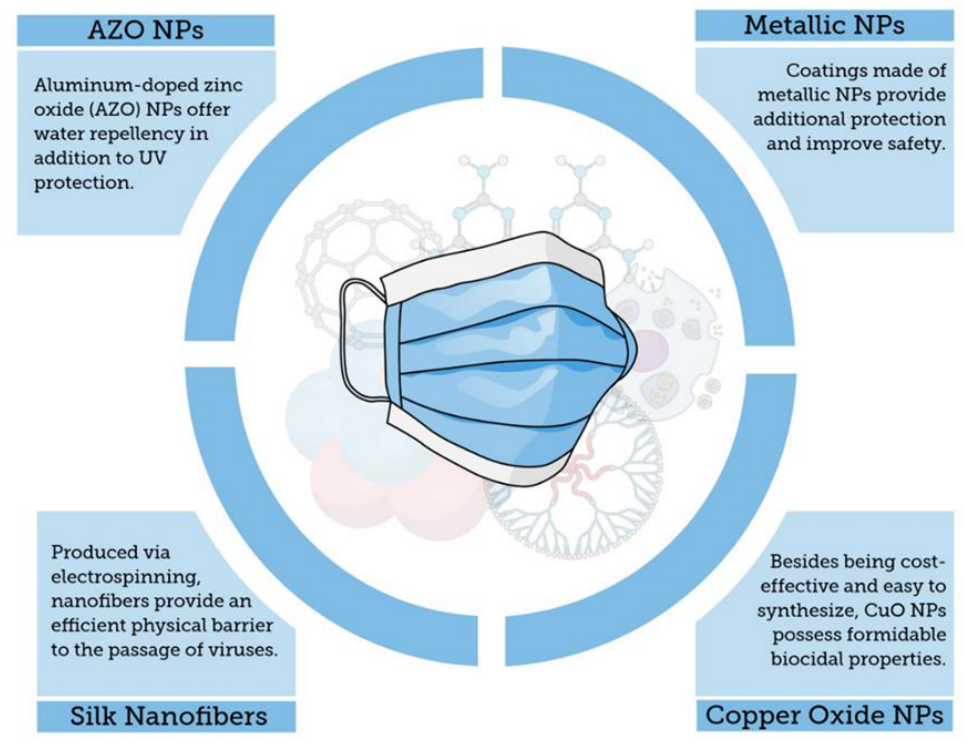
Figure 4. Summary of principal mask coatings based on nanoparticles to prevent pathogen adhesion to surgical masks.